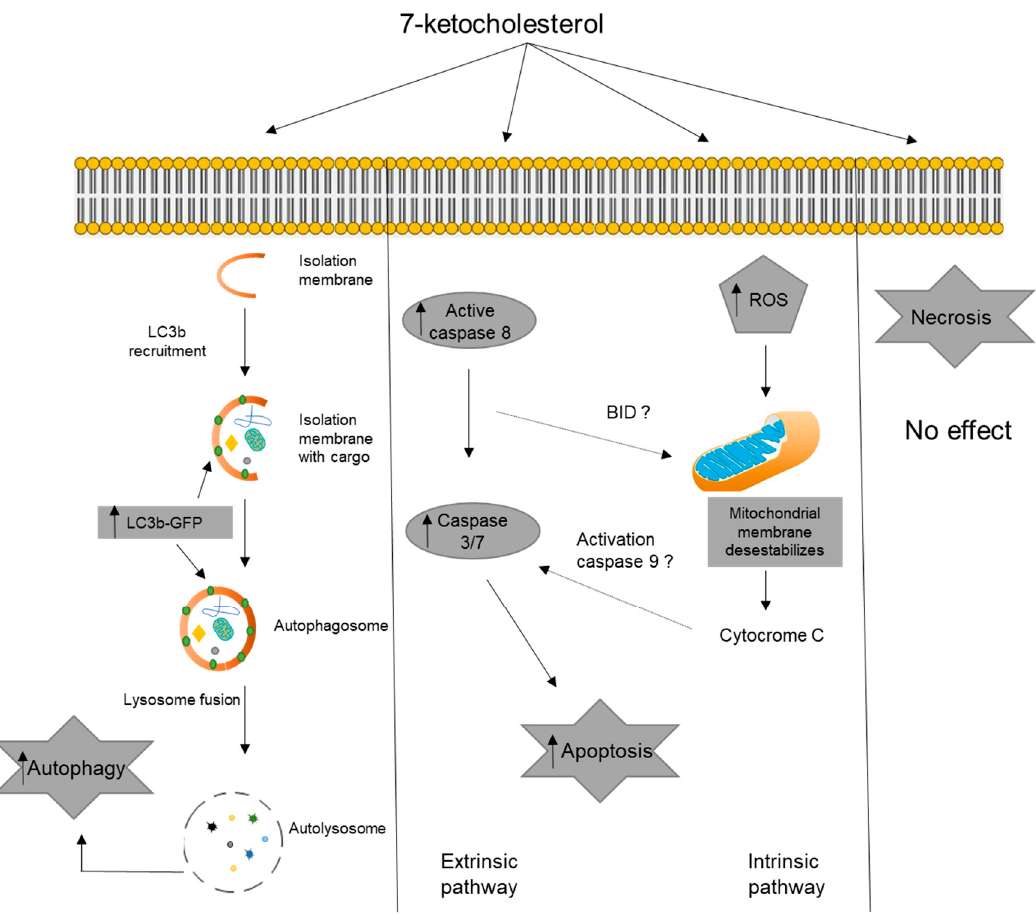
Scheme 1. Scheme of cell death promoted by 7-KC in